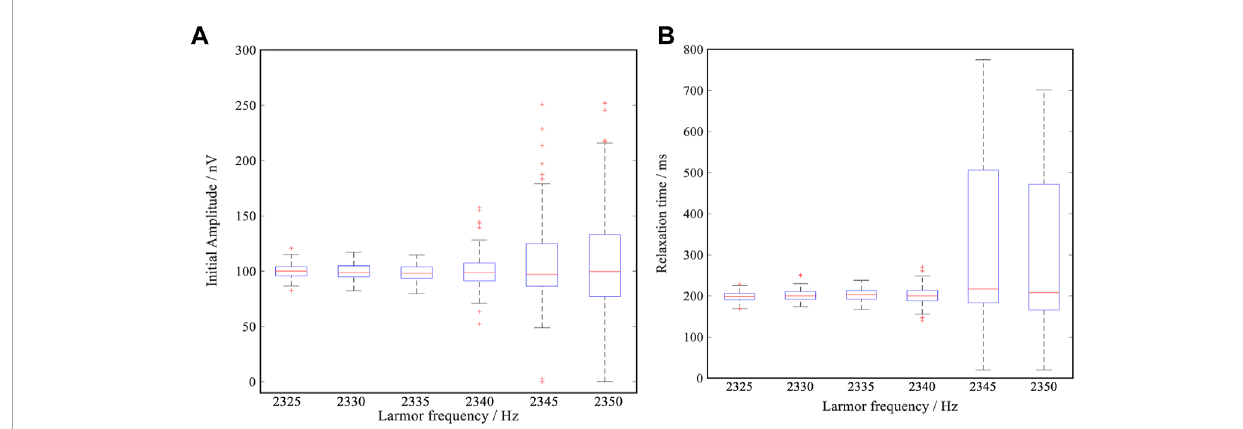
FIGURE 6 The fitting errors of relevant parameters at different Larmor frequencies; (A) Boxplot of initial amplitude fitting values at different Larmor frequencies; (B) Boxplot of fitted relaxation time values at different Larmor frequencies.